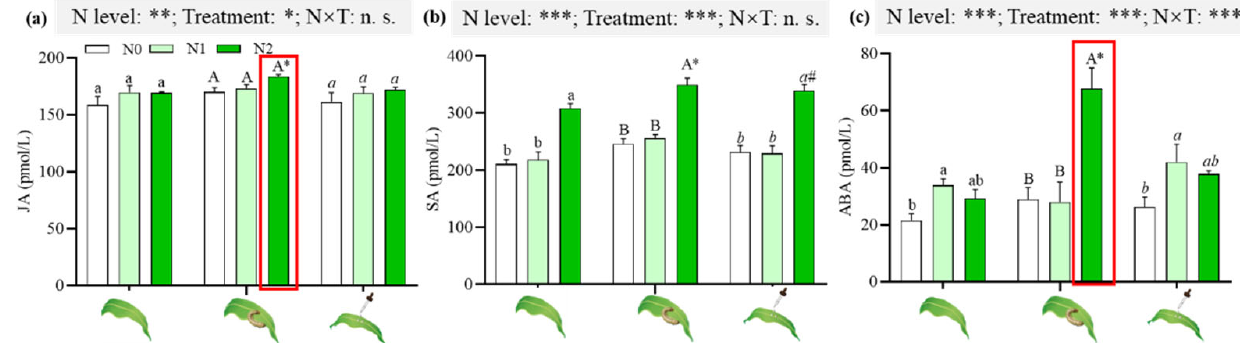
Figure 4. Effects of N supply on the phytohormones of maize under different induced treatments. The red box shows the significantly higher phytohormones in S. frugiperda attacked maize than in untreated and JA treated maize when plants were grown in N2 soil. GLM results of testing for N level and induced treatment effects are shown (n.s., not significant; * p < 0.05; ** p < 0.01; *** p < 0.001); different lowercase, uppercase and italic lowercase letters above the bars indicate significant differ ‐ ences among different N levels under the same induced treatments. The asterisk “*” above the bars indicates significant differences between maize with and without S. frugiperda attack; “#” above the bars indicates significant differences between maize with and without JA application.